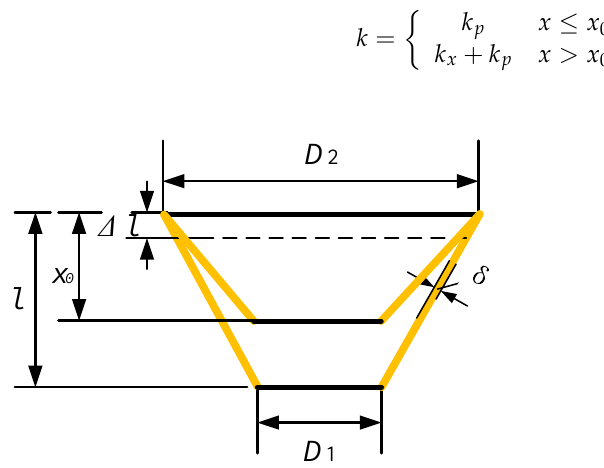
Figure 3. Parameters of the rubber